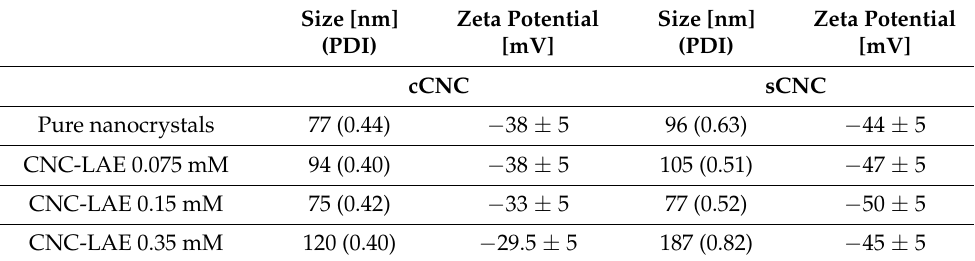
Table 2. Hydrodynamic diameter and zeta potential of pure cellulose nanocrystals and those in the mixtures with ethyl lauroyl arginate. Contents of CNCs, 0.3 wt%. Size